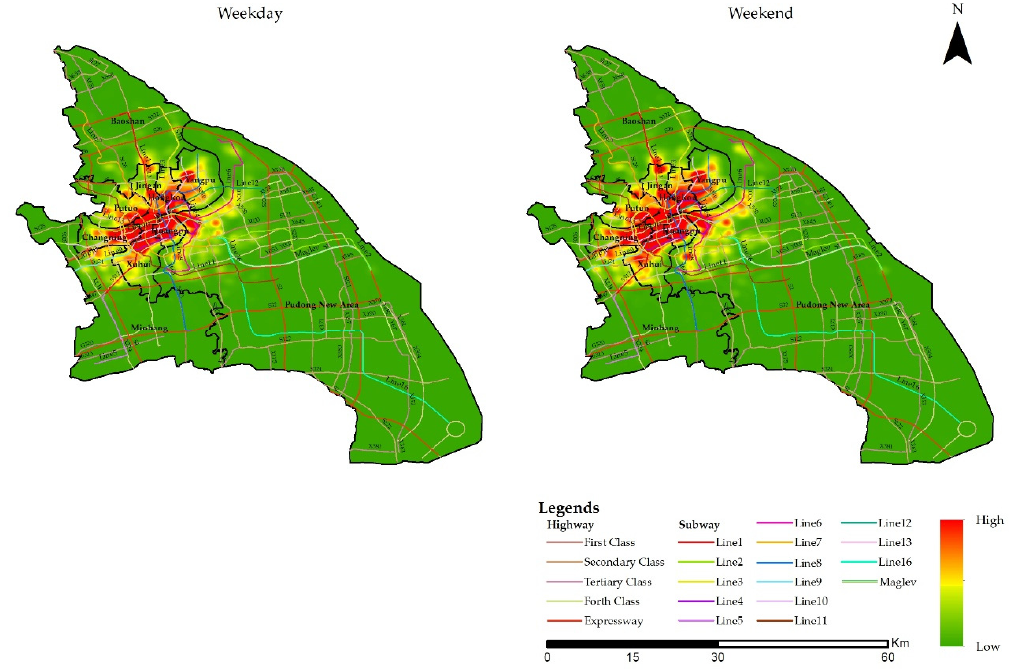
Figure 10. Check-in density of males during weekday and the Figure 10. Check ‐ in density of males during weekday and the weekend.